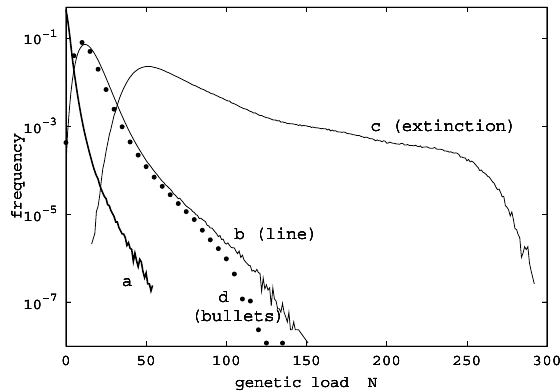
Fig. 6 – Distribution of genetic load for the four cases ((a)-(d)) de- scribed in the text.